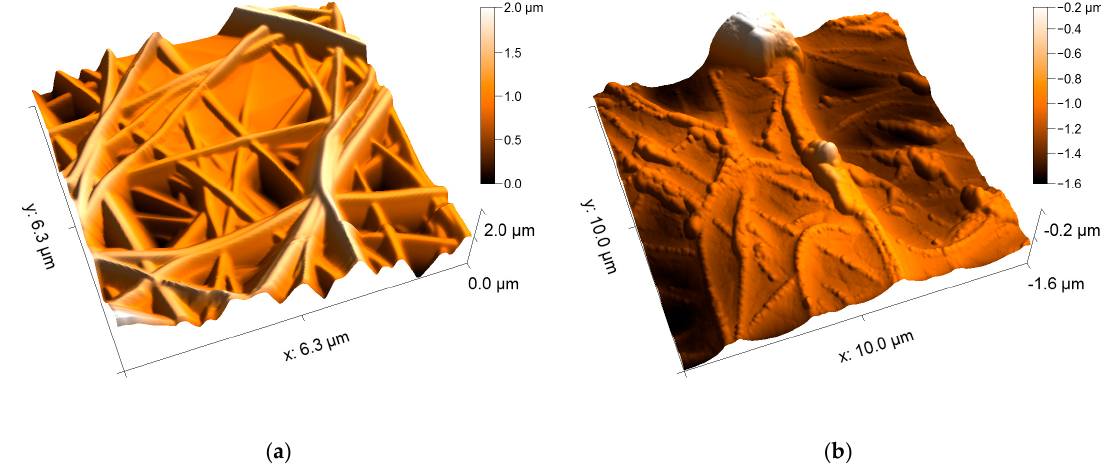
Figure 4. AFM (atomic force microscopy) images of PAN (polyacrylonitrile) nanofiber mats: ( a ) pure PAN; ( b ) pure PAN dip ‐ coated in magnetite nanoparticle dispersion and dried at air.